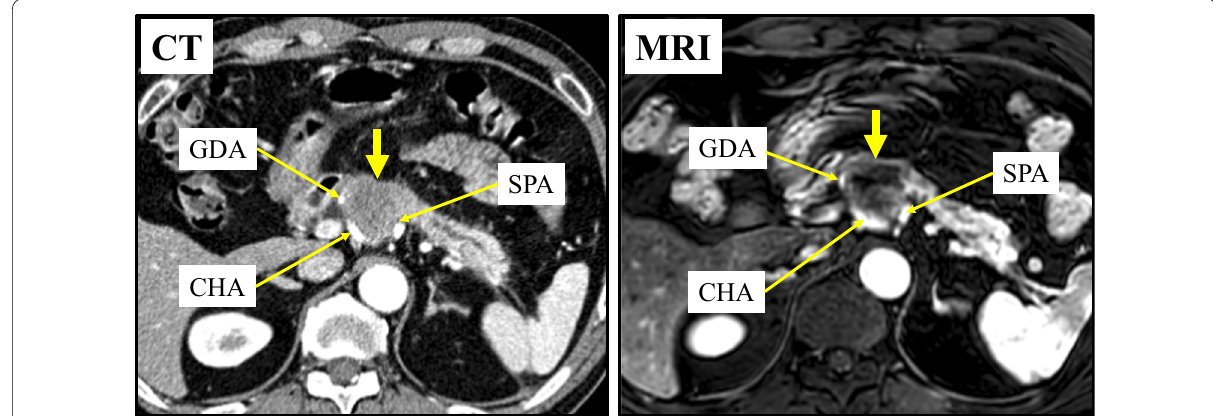
Fig. 1 Contrast-enhanced computed tomography (CT) and magnetic resonance imaging (MRI) showing a 35-mm hypovascular tumor (yellow arrow). The tumor is in contact with the GDA, CHA, and SPA. CHA common hepatic artery, GDA gastroduodenal artery, SPA splenic